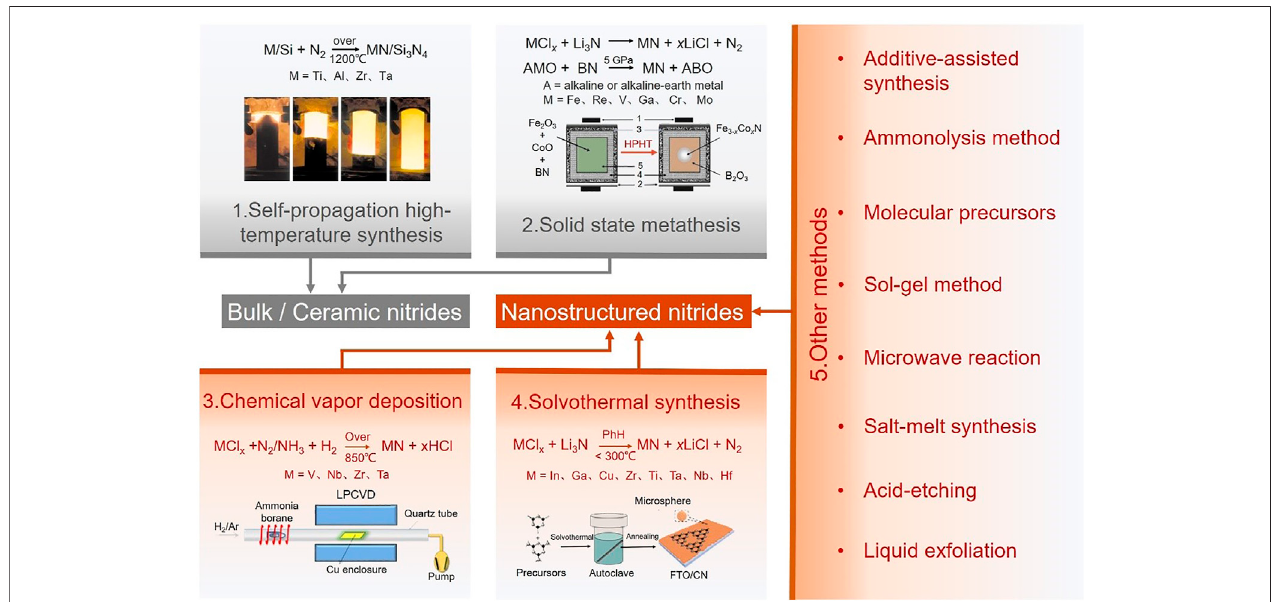
FIGURE 2 | Schematic illustration of various synthetic methods to inorganic nitrides, where methods 1 and 2 are mostly used to produce bulk or ceramic nitride materials (marked in grey), and methods 3, 4 and 5 are mostly used to prepare various nitride nanomaterials (marked in red). Method 1 of self-propagation high- temperature synthesis reproduced with the permission from Amiour et al. (2016). Method 2 of solid state metathesis reactions reproduced with the permission from Lei and Zhang (2018). Method 3 of chemistry vapor deposition reproduced with the permission from Song et al. (2015). Method 4 of solvothermal synthesis reproduced with the permission from Xie et al. (2016). Recently, some new synthesis methods for nitride nanomaterials are derived from the above four methods, including additive-assisted synthesis, ammonolysis, molecular precursors method, sol-gel, microwave reaction, salt-melt synthesis, acid-etching and liquid exfoliation.